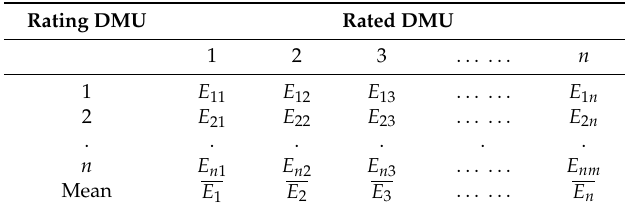
Table 2. A Generalized Cross-Efficiency Matrix (CEM)